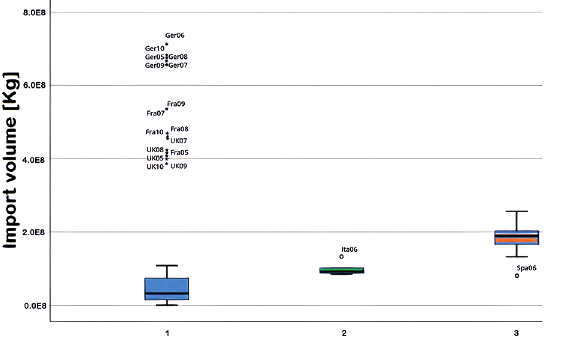
Figure 4. Box diagram of the pre-crisis import variable according to the clusters of the first two-stage clustering level (source: own elaboration)